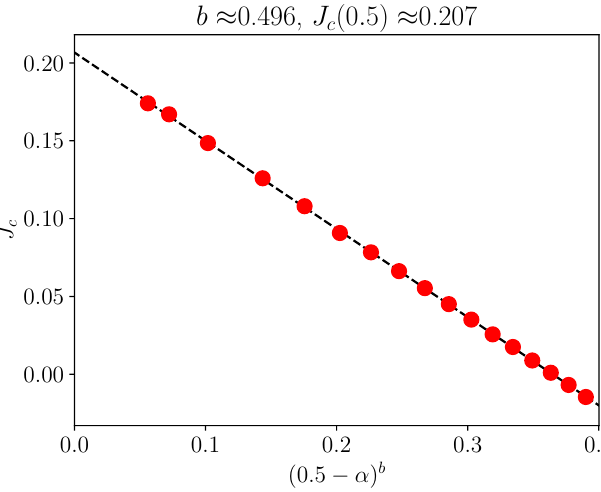
Figure 7: The phase boundary between trivial and FM phases extracted from the Binder ratio crossing (as shown in Fig. 5 for α = 0.495) fits the scaling formula in Eq. (14). Here, the values of α used are in the range [ 0.35,0.497 ] . This scaling is ( 0.5 ) ≈ 0.21. used to extrapolate the value of J at the DQCP to be J c c